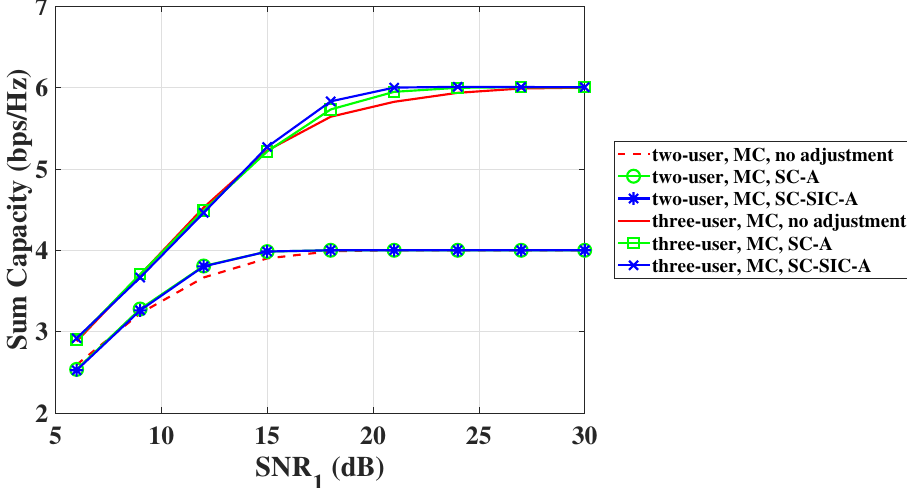
Figure 6. The BER performance for each user of multi-user NOMA VLC system, when K = 3.